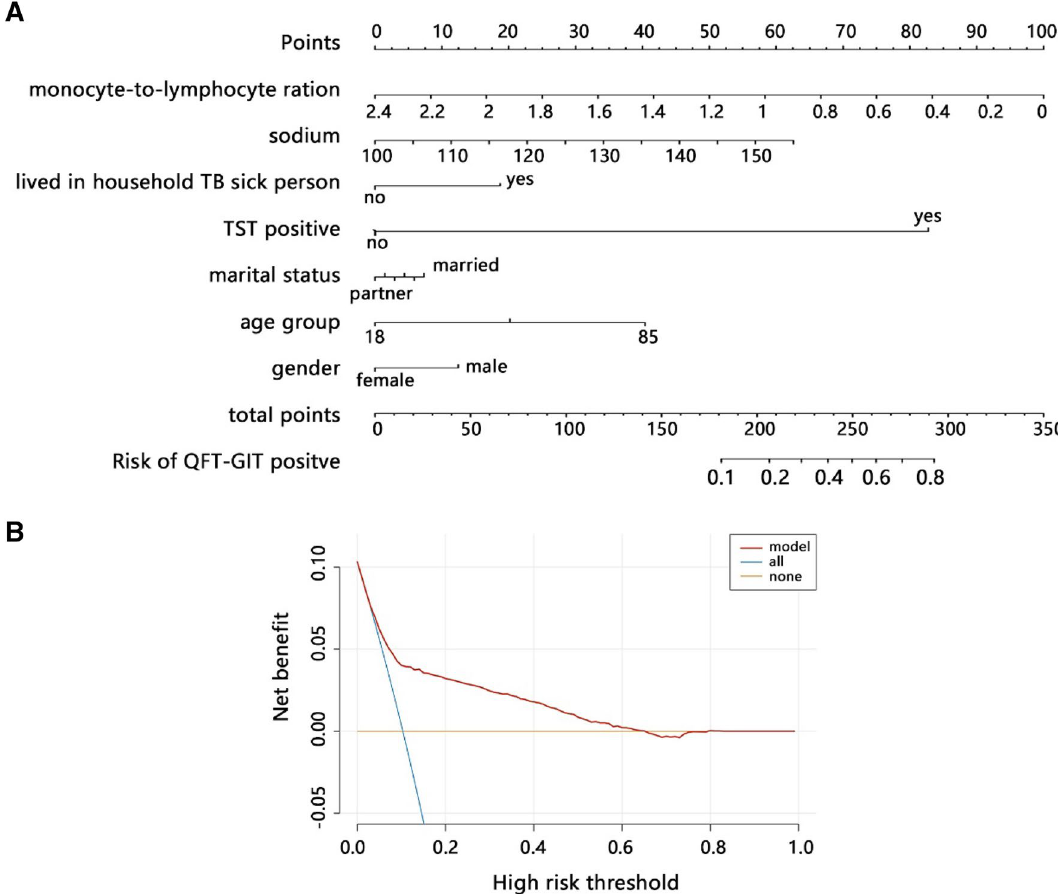
Figure 2. Development of the comprehensive nomogram model and its performance on QFT-GIT results. ( A ) Nomogram was constructed with the laboratory signatures and clinical variables. ( B ) Decision curve analysis (DCA) was used to assess the clinical usefulness of the comprehensive model. The x-axis indicates the threshold probability. The y-axis indicates the net benefit.